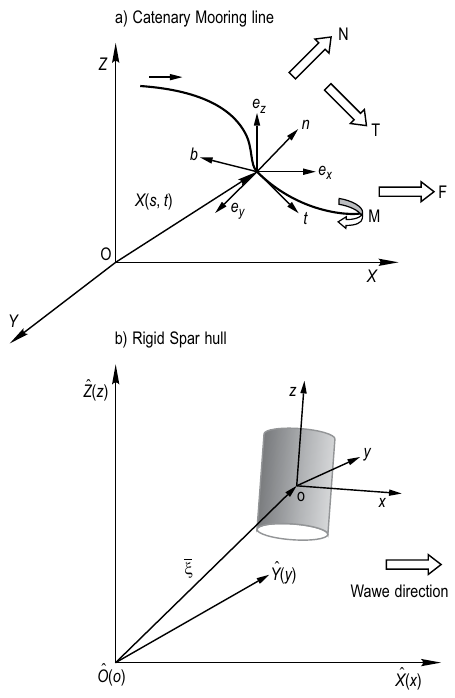
Fig. 2. Coordinate System of mooring line and spar